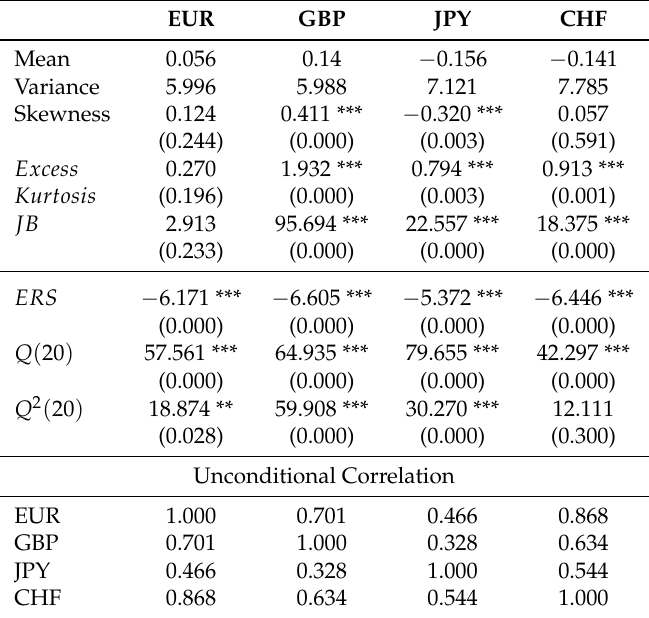
Table 2. Descriptive statistics of exchange rate